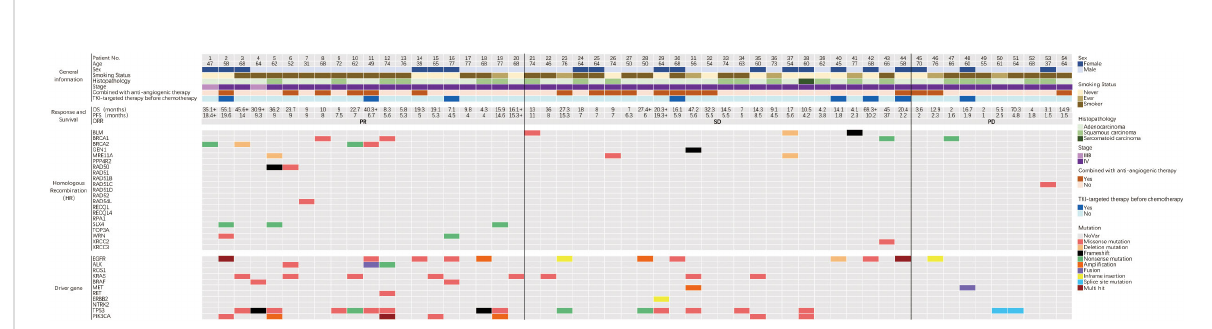
FIGURE 1 Baseline information of HR gene and driver gene mutations and the response to platinum-based chemotherapy in 54 NSCLC patients. The top panel showed clinical information and treatment. The middle panel showed response and survival, and the symbol ‘ + ’ after survival time indicated that the follow-up endpoint was not reached. The two panels below showed the HR and driver gene mutations. PFS-Progression free survival; ORR-Objective response rate; PR-Partial response; SD-Stable disease; PD-Progression